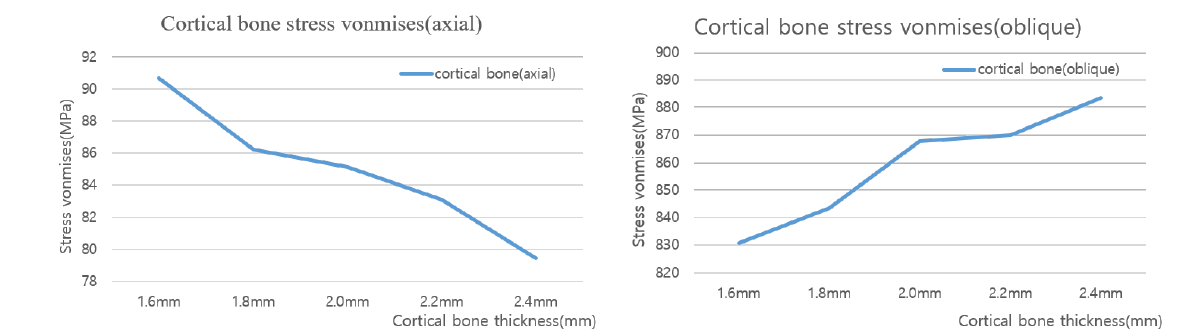
Figure 17. Cortical bone von Mises stress value